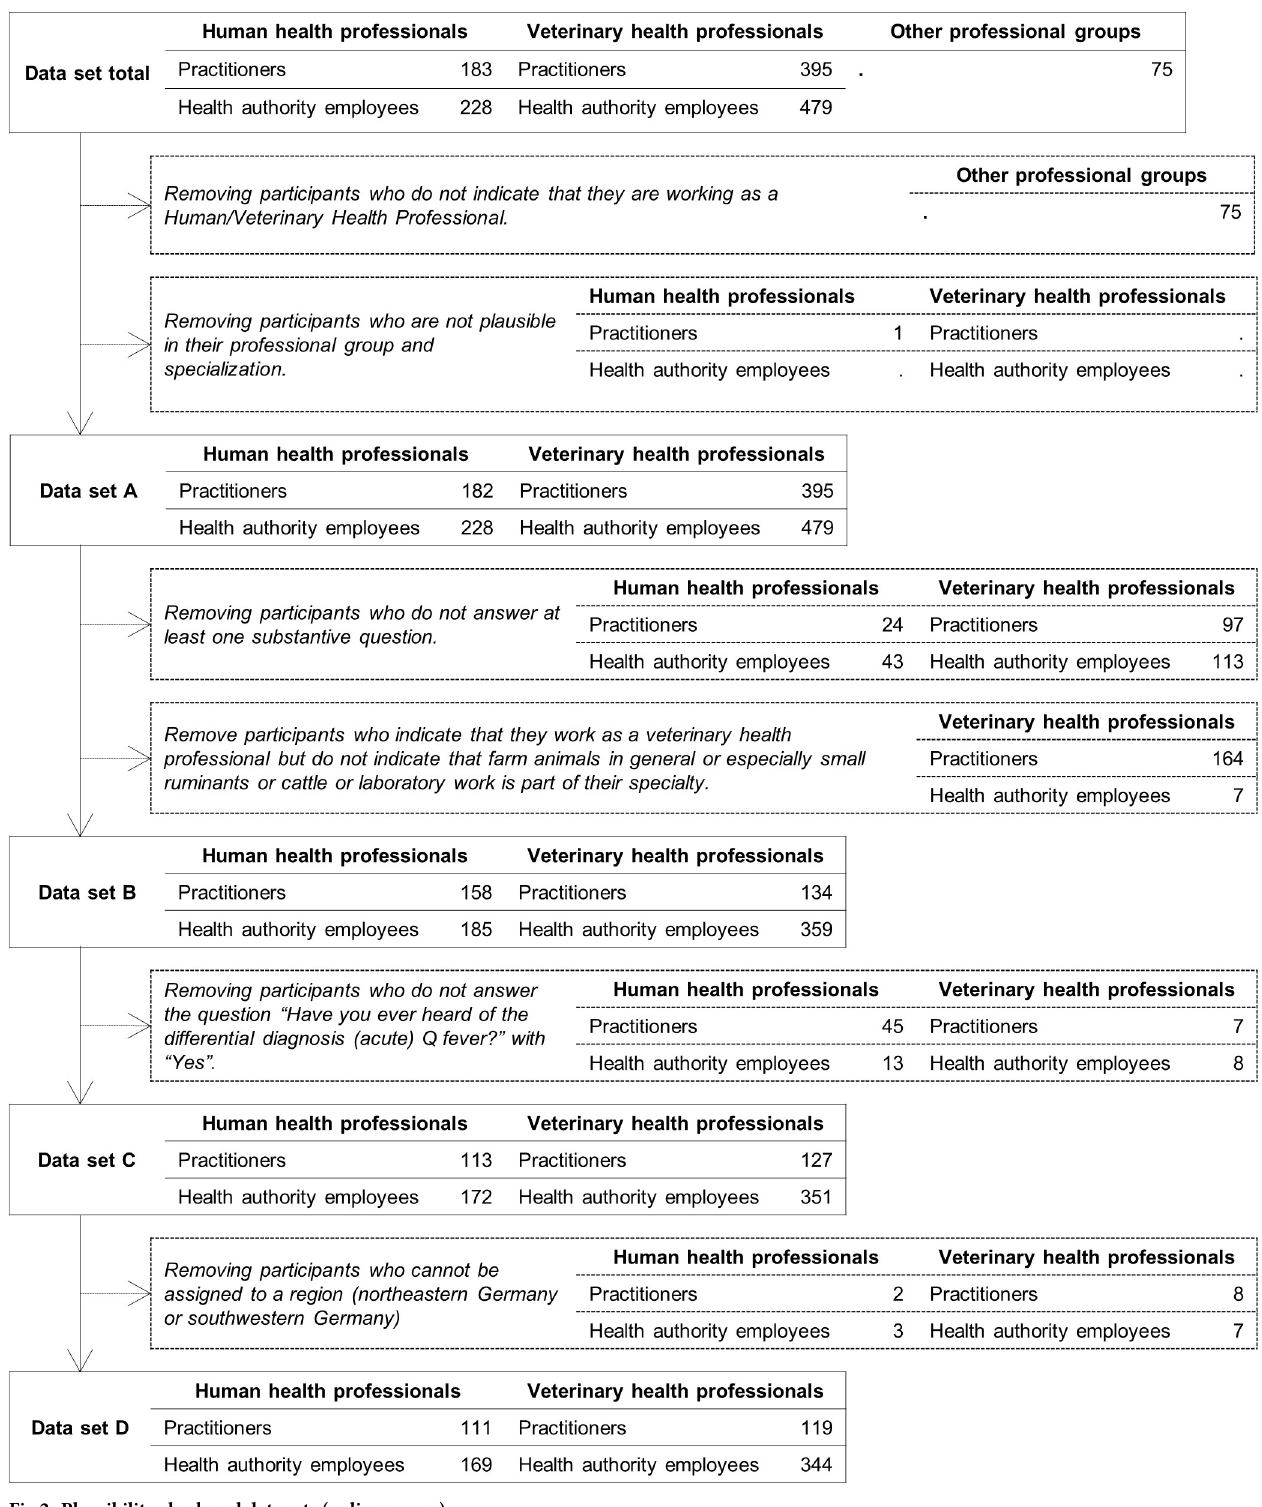
PLOS ONE | https://doi.org/10.1371/journal.pone.0264629 March 3,